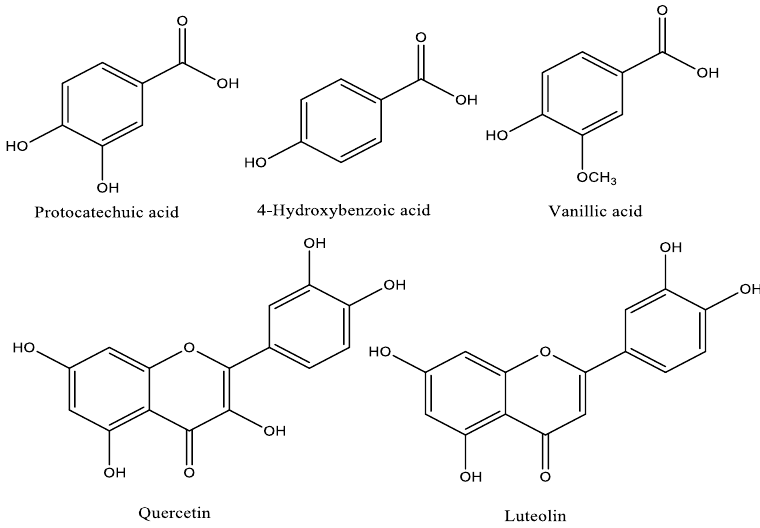
Figure 1. Phenolic compounds detected in the propolis extracts by HPLC-DAD. Column chromatographic purification of the extract afforded five compounds which were characterized as 27-Hydroxymangiferonic acid (1), Ambolic acid (2), Mangiferonic acid (3), lupeol (4), a nd β -amyrin (5). It is worthy to note that the isolated compounds are all pentacyclic triterpenoids, and terpene derivatives are known to be characteristic con- stituents of tropical propolis samples, occurring in high amounts and easy to isolate. The NMR data of the isolated compounds are given on Table 2 while their structures are given in Figure 2. The compounds isolated in good amounts, particularly 27-Hydroxymangi- feronic acid (1), Ambolic acid (2), and Mangiferonic acid (3) were also tested for their ef- fects on microbial virulence factors. Table 2 . NMR data (ppm) of isolated compounds .